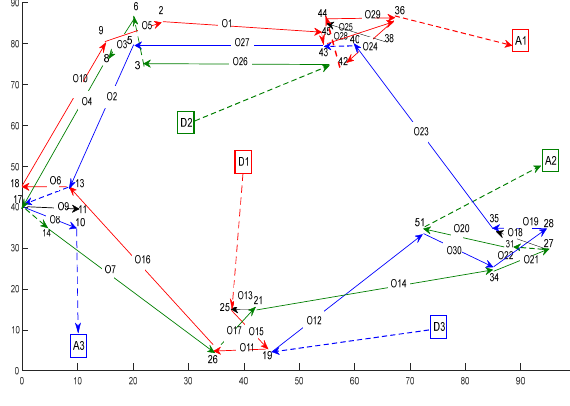
Fig. 6. Result for instance 𝑺𝑭𝑻𝑳𝟓 / 𝑹𝑪𝟓𝟎 / 𝟑𝟎 /